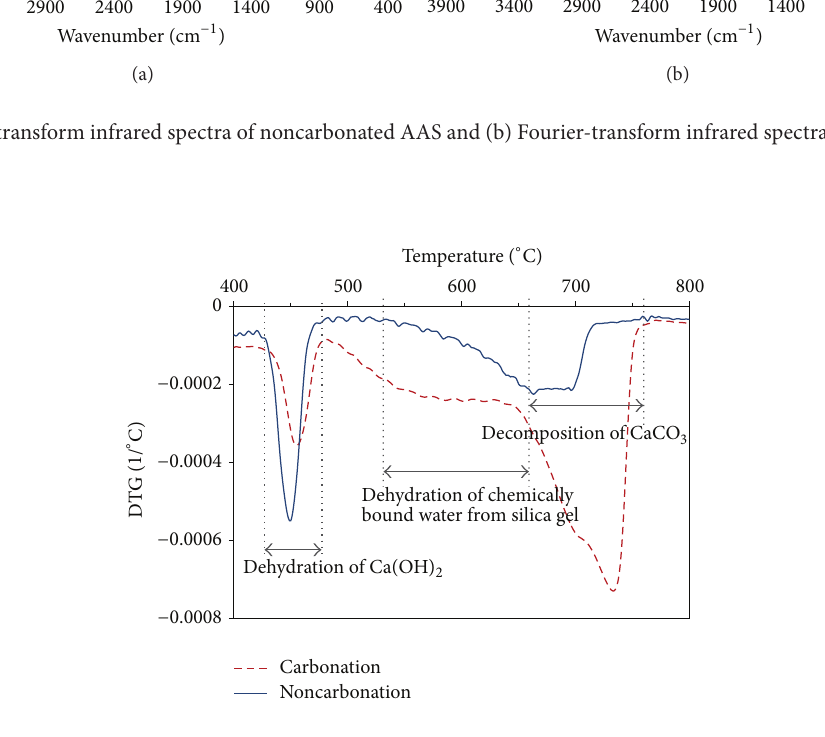
Figure 11: Differential thermograms (mass loss downwards) of noncarbonated and carbonated OPC